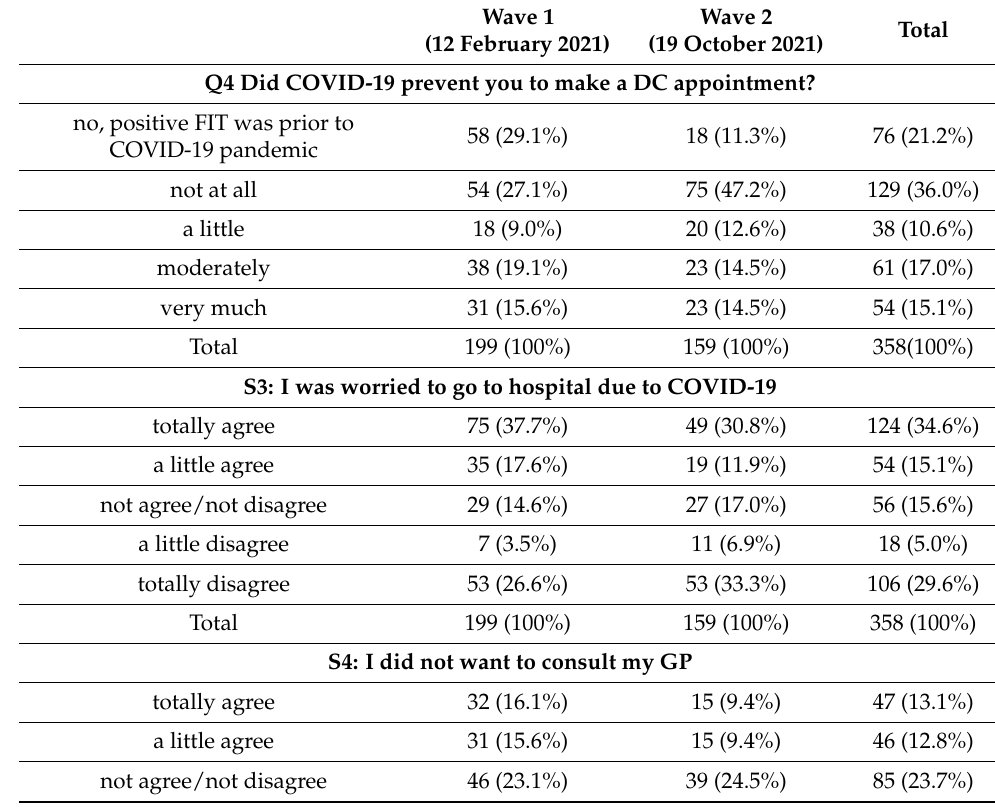
Table 5. Survey questions and statement results of the no DC group only at the time of the survey (according to survey waves), in absolute numbers and